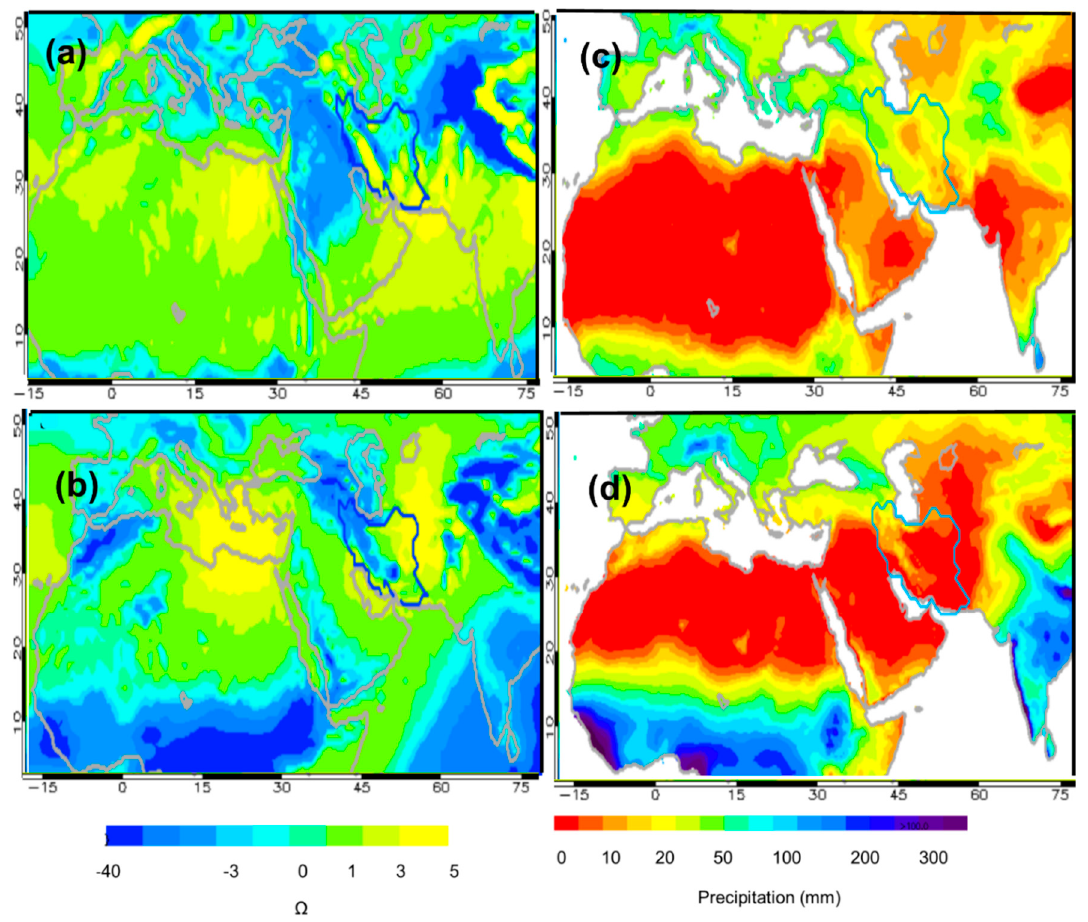
Figure 6. The stability of atmosphere (Omega ω ) variations ( a , b ) and precipitation distribution ( c , d ) over Iran and nearby regions for wet and dry seasons, respectively (1981–2015).